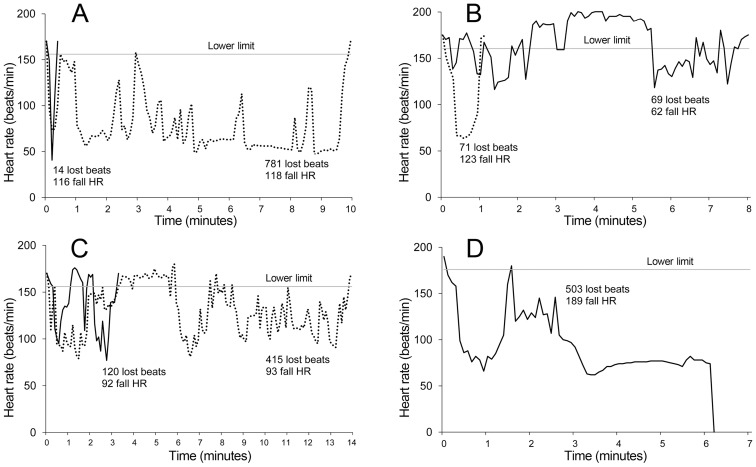
Changes in heart rate during several different intubations.Two intubations (dotted and solid lines representing different intubations from separate children) are shown for comparison of how the loss of heart beats can be poorly correlated with reduction in heart rate. A, shows two intubations with similar fall in heart rate (fall HR) and more than 50 fold differences in lost beats, B, shows two intubations where the number of lost beats was similar but the fall in heart rate 50% greater, C, shows two examples where there was a more than a three-fold difference in lost beats against reduction in heart rate and D, is the one child who died in the study having lost 503 beats before an asystolic arrest. Inter-bradycardia tachycardia is also apparent in B. Note that the scales on the x-axes are different for each graph.